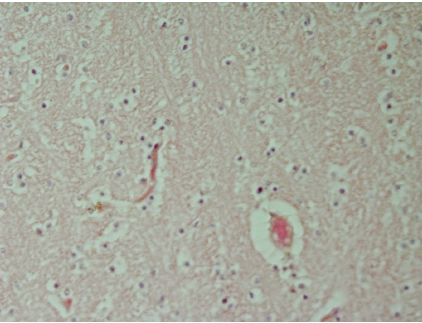
Figure 9: The cerebrum adjacent to the parasitic granuloma show- ing congestion, oedema, and mild perivascular cuffing. H&E × 200.